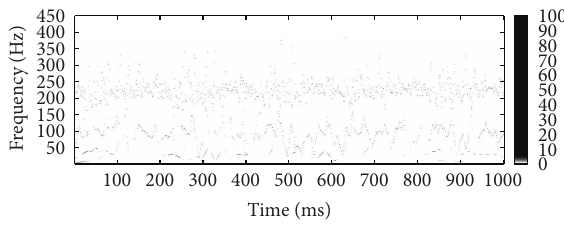
Figure 23: Intensity matrix of outer ring fault signal.